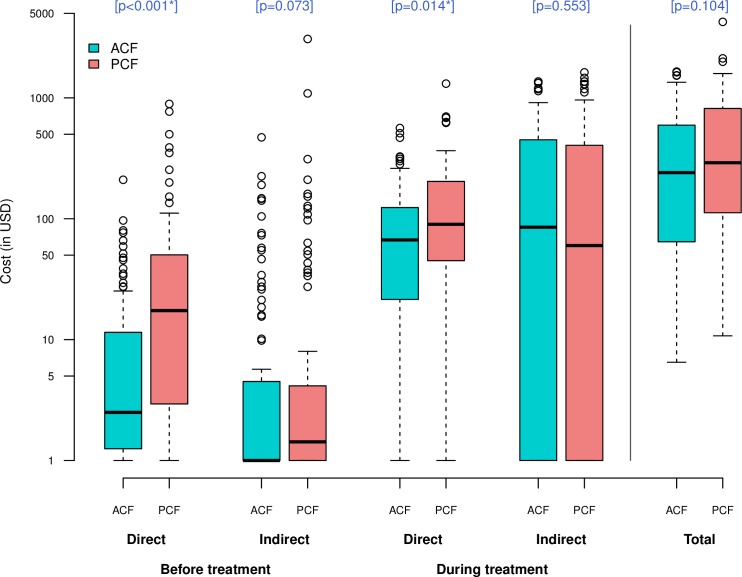
Comparison of cost distribution between ACF and PCF.Box-and-whisker plots indicate the median, 25th and 75th centiles, and the range of values. All values less than one were converted to one in order to use a log scale for the y-axis. *Significant difference (P<0.05).